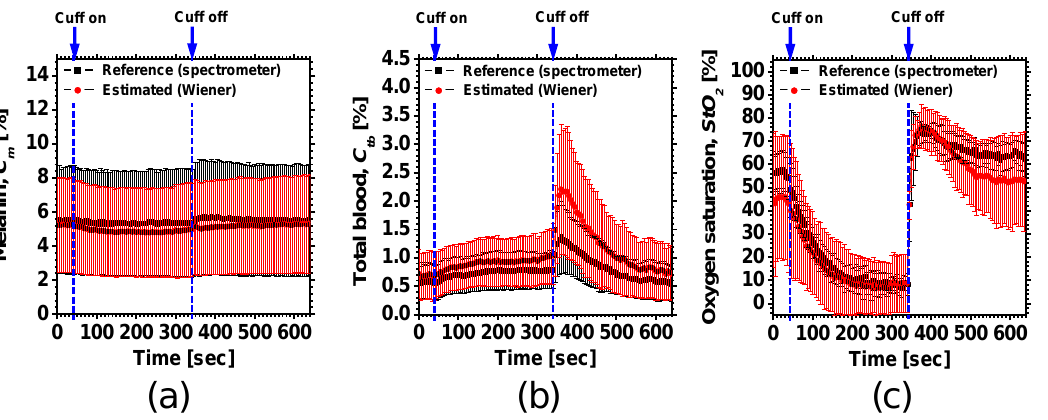
Figure 8. Time courses of ( a ) C squares in Figure 6) are compared with the reference values from the spectrometer recordings. The error bars show the standard deviations ( n =